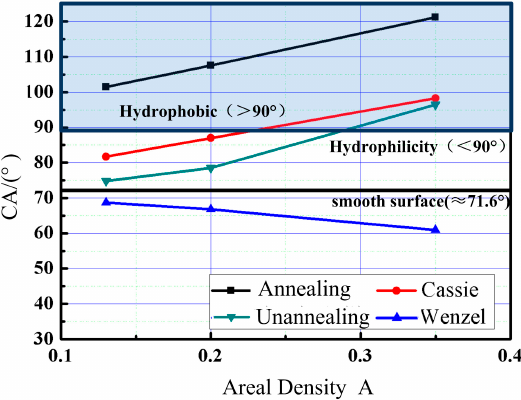
Figure 11. The relationship between the areal density of micro-dimple array and the CA.